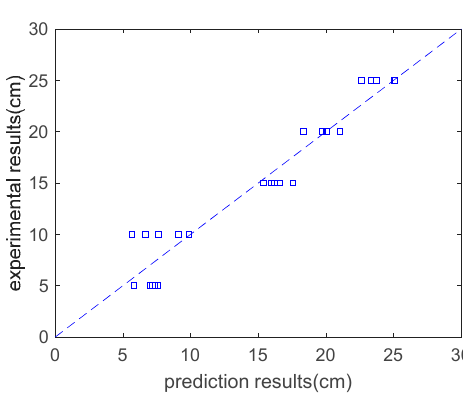
Figure 4. Expression tree for slump.